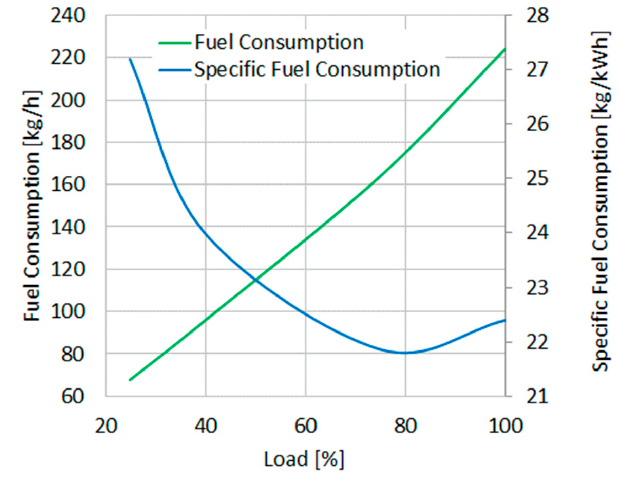
Figure 3. Fuel consumption curves.